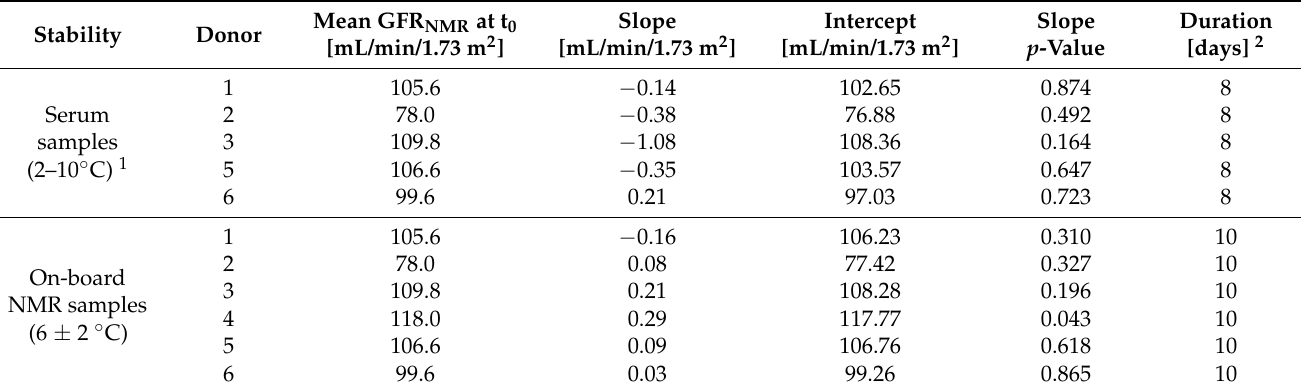
Table 3. GFR NMR score stability during storage of human serum (2–10 ◦ C) and of prepared NMR